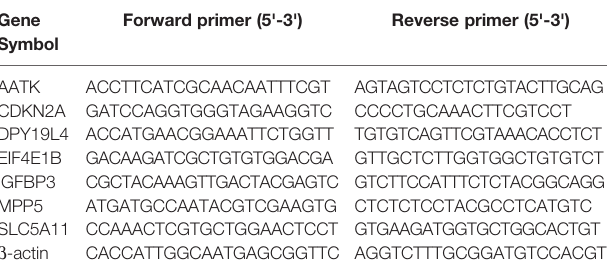
TABLE 1 | The sequences for primers for